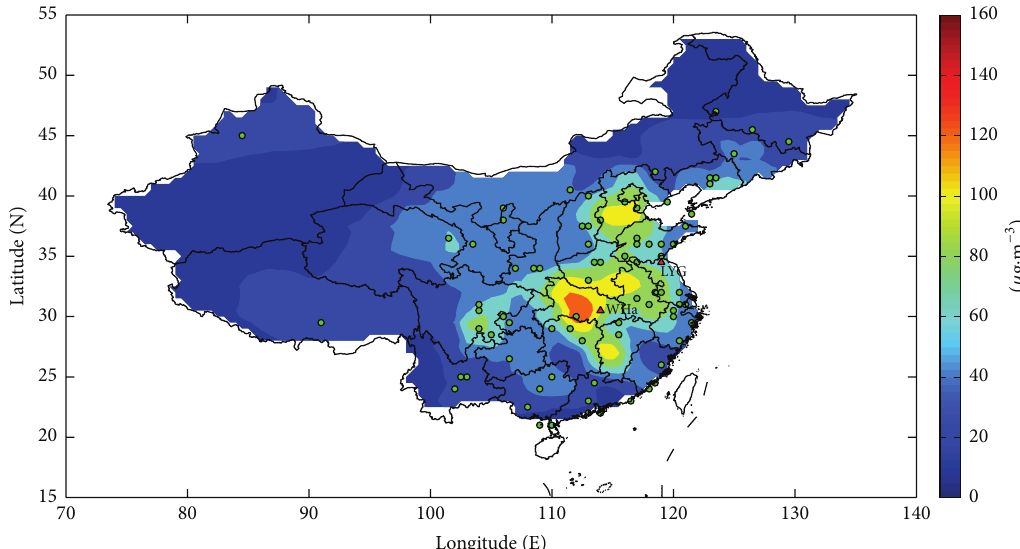
Figure 7: The mean field of PM 2.5 concentrations ( 𝜇 g/m 3 ), where “ ∘ ” represents that in this city the correlation coefficient is positive and “ 󳵻 ” represents that the correlation coefficient is negative in this city.